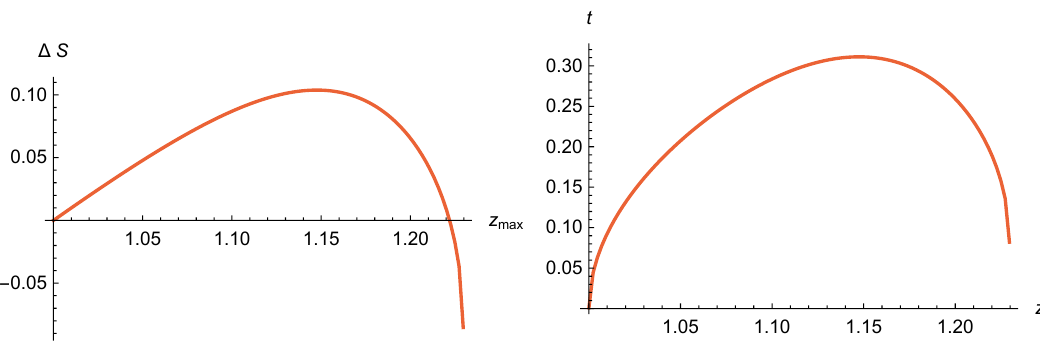
Figure 9 . For d = 4 and λ GB = − 7 / 36 which violates the bound (4.23), the extremal surface ‘area’ ∆ S and the time t are no longer monotonic functions of z max . Instead, they become maximum at z max ≈ 1 . 148 . As a result, the time evolution of extremal surface ‘area’ stops at the finite time t (1 . 148) ≈ 0 . 311 . See figure 10 below. For simplicity, we set V d − 2 / (4 G N ) = 1 in this and the